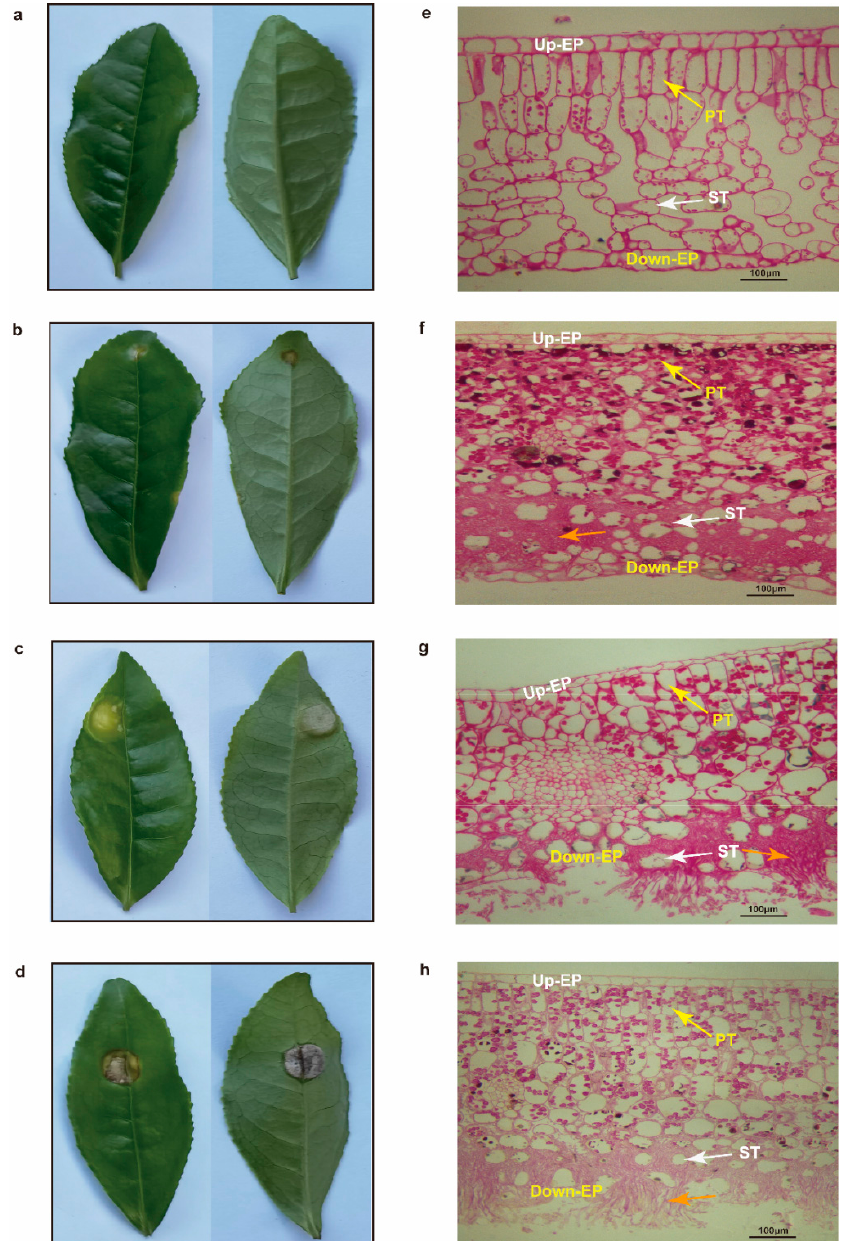
Figure 6. Observation of the stages and PAS staining of tea leaves. Healthy leaves ( a , e ) and tea leaves infected with tea blister blight at the different stages of infection: early stage ( b , f ), middle stage ( c , g ), and late stage ( d , h ). The orange arrow represents club-shaped hyphae structures of Exobasidium vexans . Up-EP: up-epidermis; Down-EP: down-epidermis; PT: palisade tissue; ST: spongy tissue. Bar = 100 μ m.